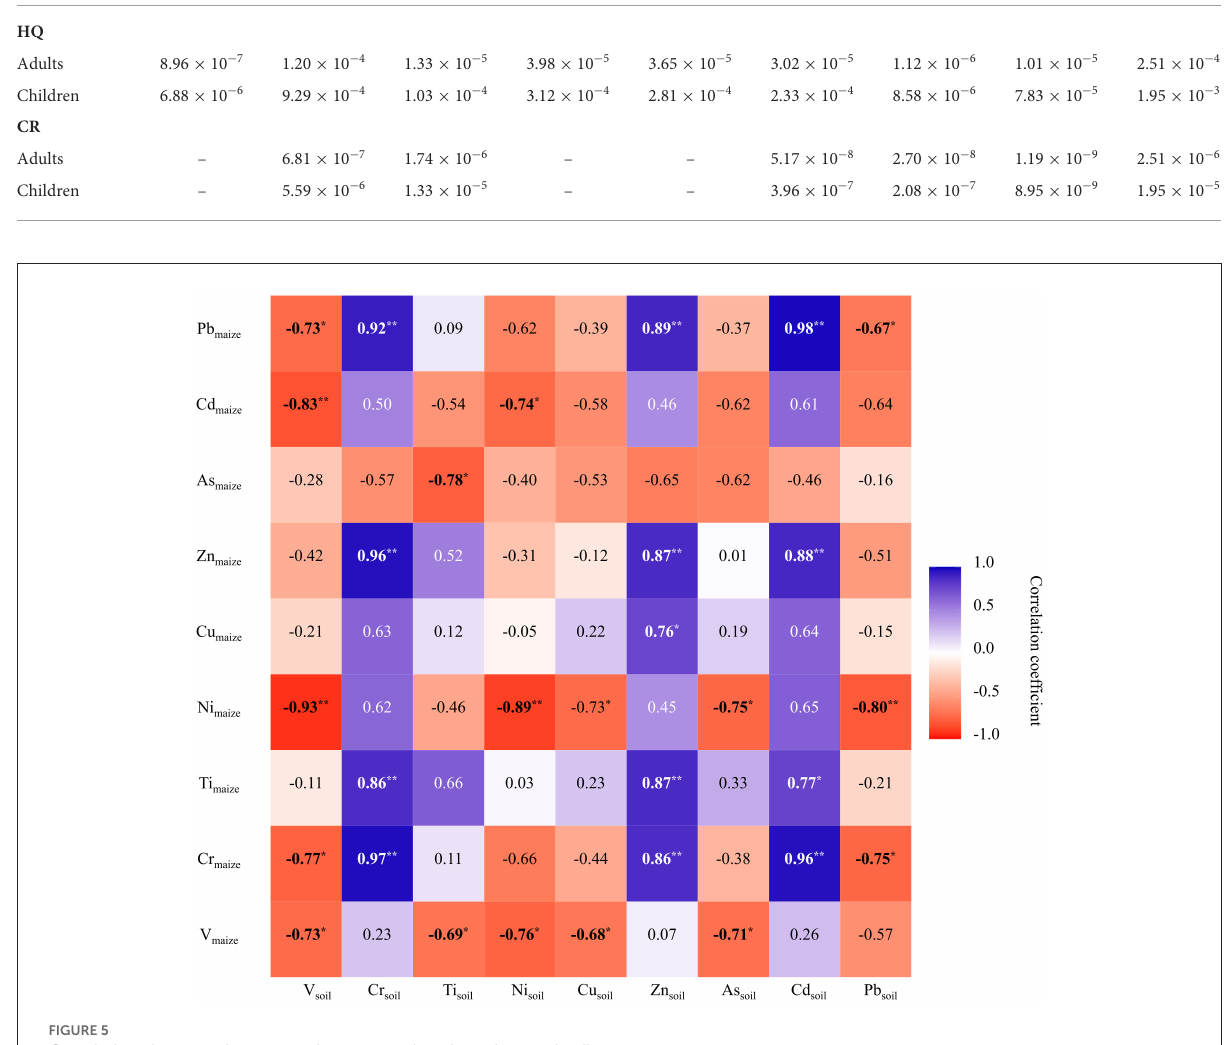
FIGURE5 Correlations between heavy metal concentrations in maizes and